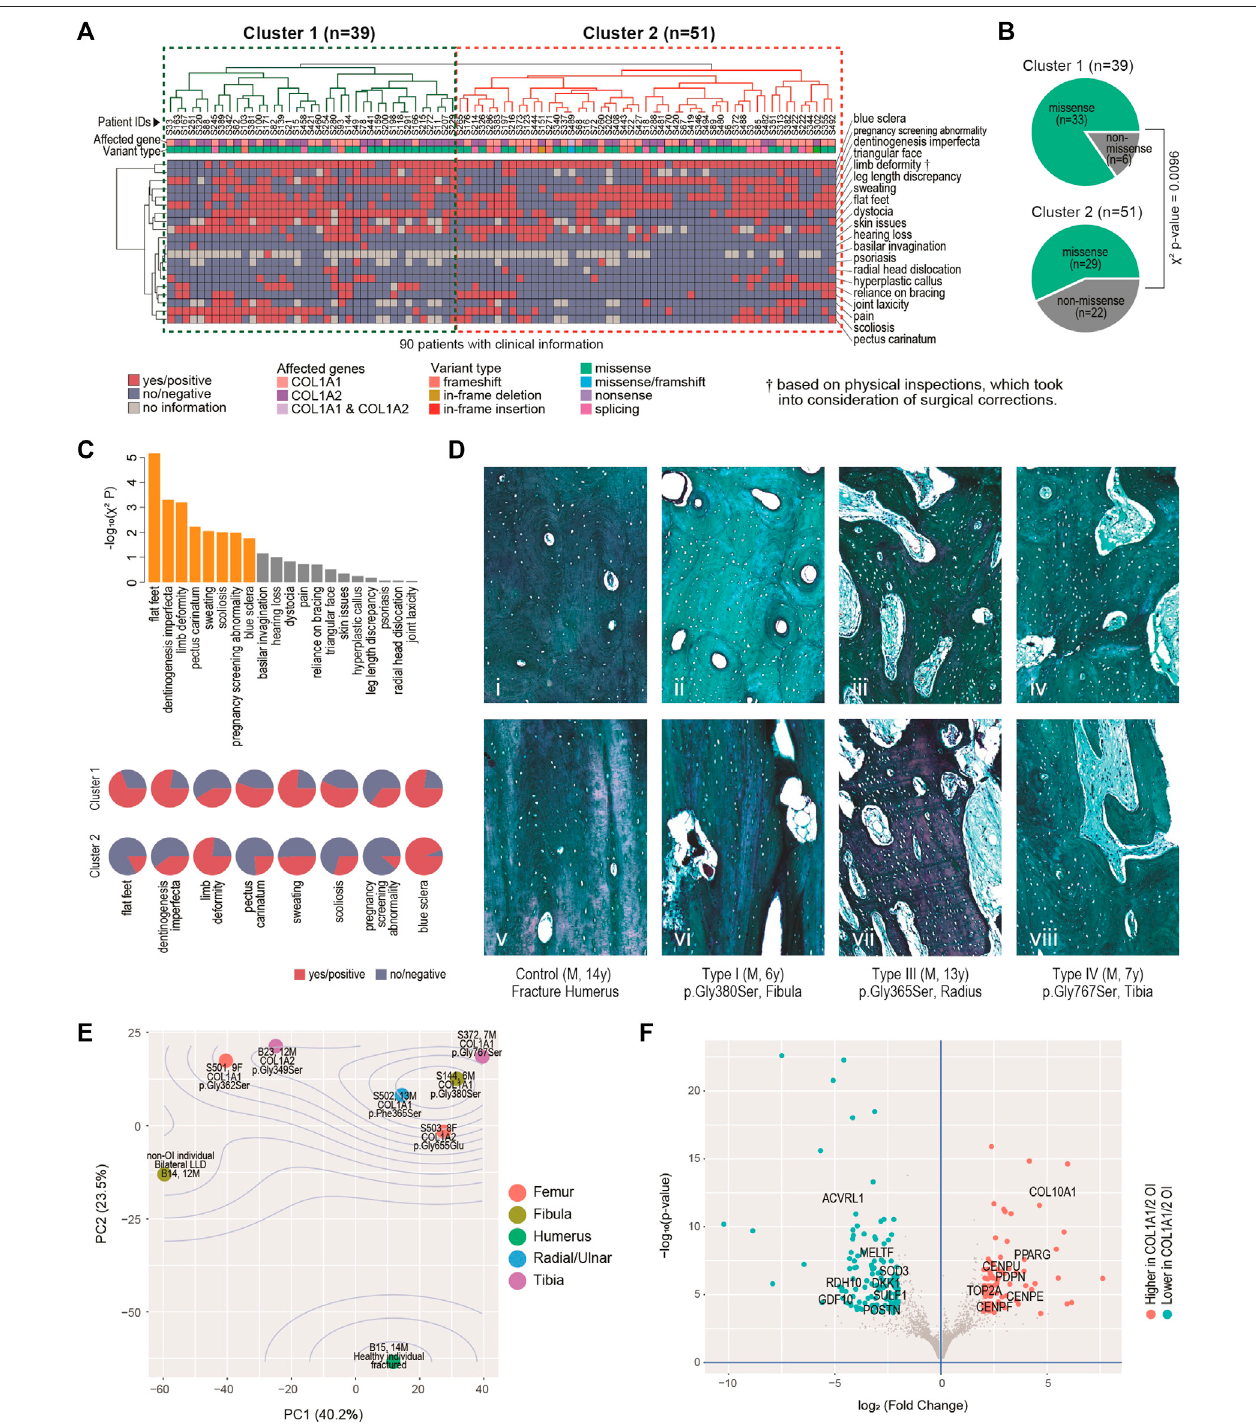
FIGURE2| Clinical,histologicalandmolecularphenotypes. (A) Heatmapshowingclinicalcharacteristicsfor90patientsaffectedbyCOL1A1orCOL1A2,andwith available information. Euclidean distance and complete linkage were used in constructing the dendrograms. (B) Enriched types of variants in the identi fi ed clusters. (C) Top: bar charts showing the clinical traits most correlated with the two clusters. Bars in orange have p < 0.05. Bottom: arrays of pie charts showing the percentages of positive traits in each of the two clusters, for the 8 clinical traits that have p < 0.05. (D) Analyses of bone histology. Goldner trichrome staining of skeletal samples from control individual (n (cid:1) 1) (i, v),proband withtype IOI(n (cid:1) 2) (ii,vi),proband withtype III OI(n (cid:1) 2) (iii,vii) and proband withtype IV OI(n (cid:1) 3)(iv,viii) harbouring different mutations in COL1A1. Haversian structure was shown by transaxial sections (i-iv). Collagen matrix alignment was shown by sagittal sections (v-viii). (E) Diagram of Principal component (PC) analysesshowing the sample-sample relationships in aset ofeight bulk transcriptome dataderived from osteoblasts of sixOIand twonon-OI patients. Percentages on axes indicate fraction of variance explained. (F) Volcano plot showing the differentially expressed genes between the six OI samples with mutations on COL1A1/2 and the two